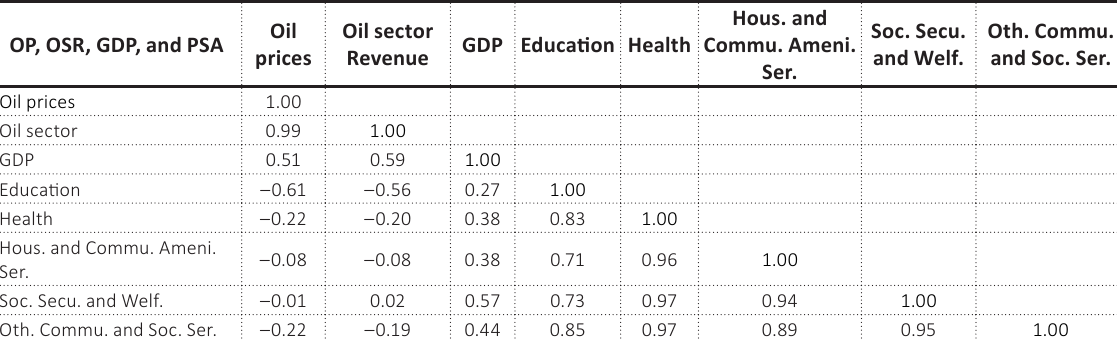
Table 2. Cause and effect relationship among OP, OSR, GDP, and PSA in Saudi Arabia (2011–2018) Source: Own calculations based on data of National account statistics and oil statistics (annual statistics 2019) (available at http://www.sama.gov.sa/en-US/EconomicReports/Pages/YearlyStatistics.aspx ). OP, OSR, GDP, and PSA